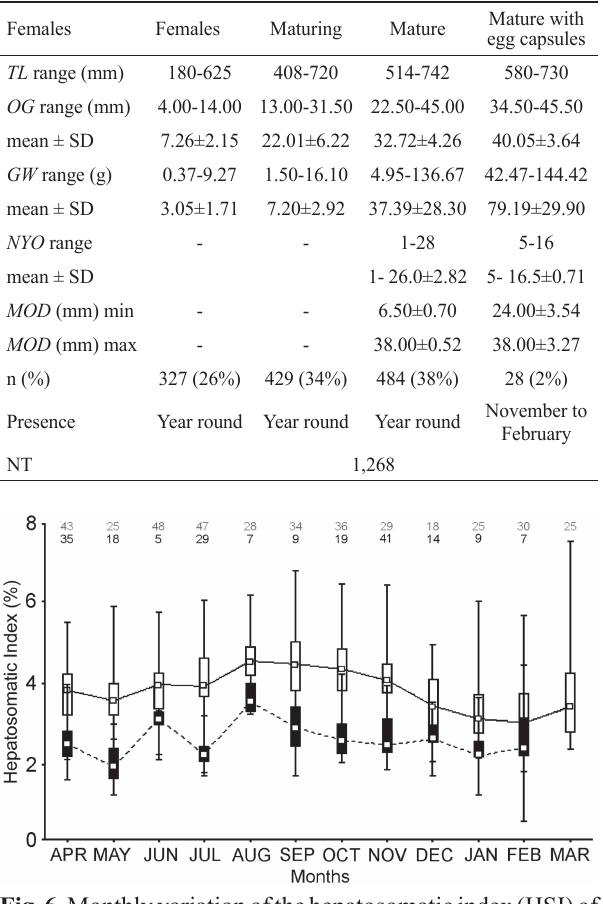
Tab. 4. Characteristics of the maturity stages of females of Sympterygia bonapartii from San Matías Gulf (Argentina). TL = total length; OG = width of the left oviducal gland; GW = weight of the paired ovaries; MOD = diameter of the largest yolked ovarian oocyte; NYO = mean number of yolked ovarian oocytes.